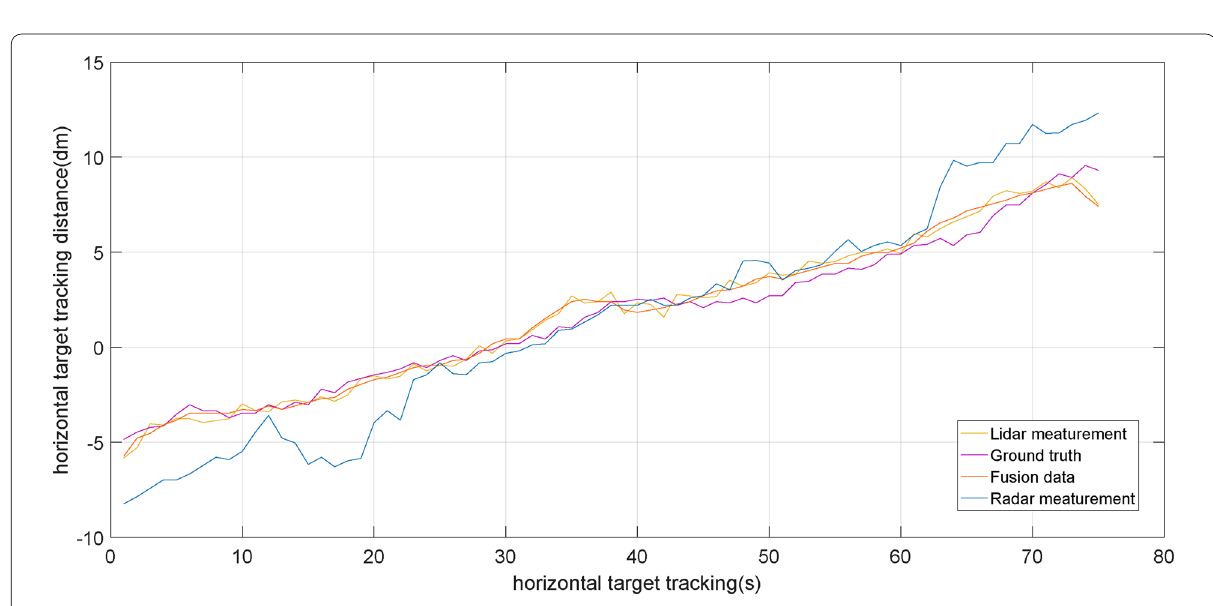
Figure 9 Horizontal tracking results of autonomous